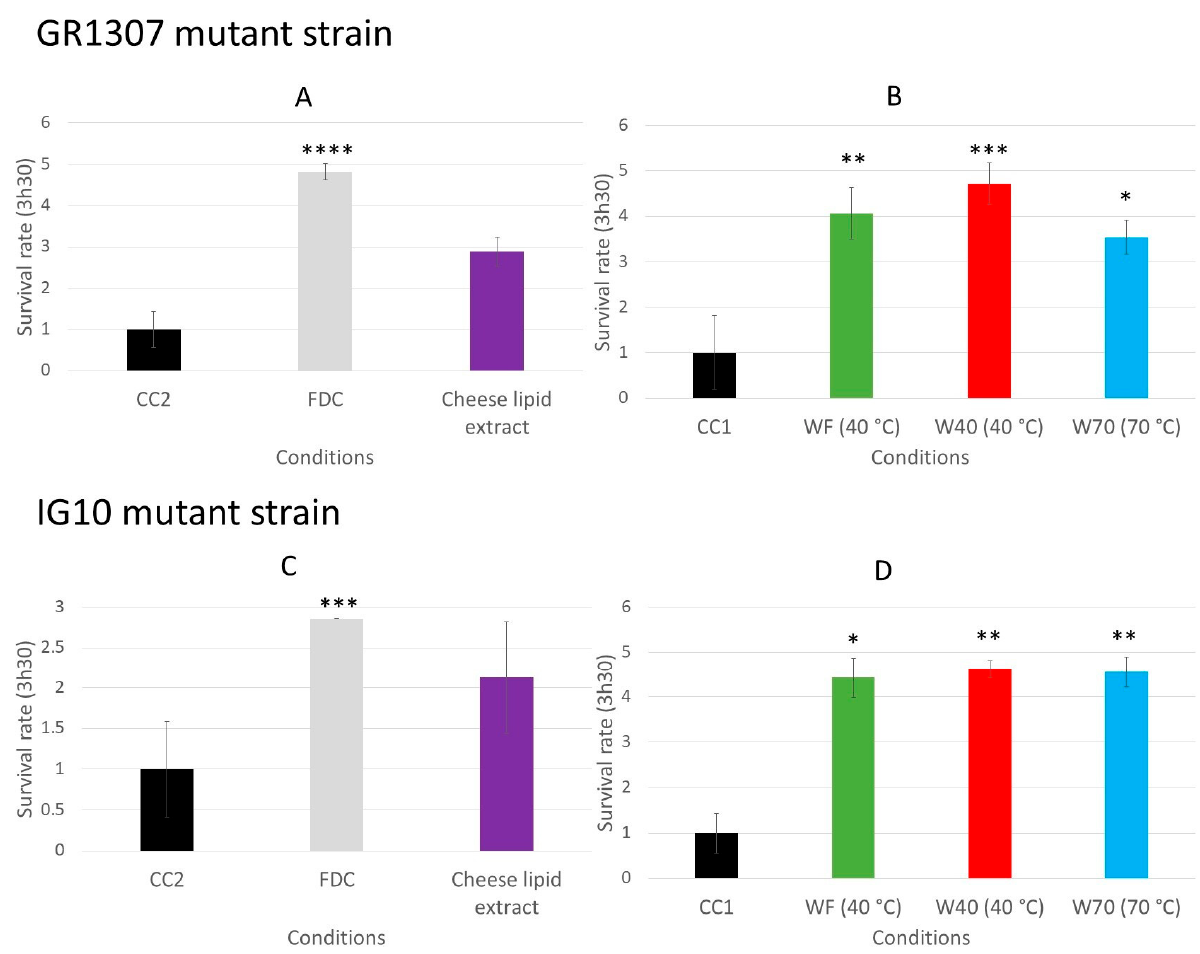
Figure 7. The relative survival rates of the C. elegans GR1307 strain (DAF-16 loss-of-function) ( A , B ) and IG10 strain (TOL-1 loss-of-function) ( C , D ) on an oxidative medium after 5 days of incubation on a medium supplemented with the cheese extracts (FDC (freeze-dried cheese), cheese-lipid extract and aqueous extracts WF, W40 and W70). The conditions were considered significantly different from the control when the p -value was lower than 0.05 (*), 0.01 (**), 0.001 (***) or 0.0001 (****) (Kruskal–Wallis test).